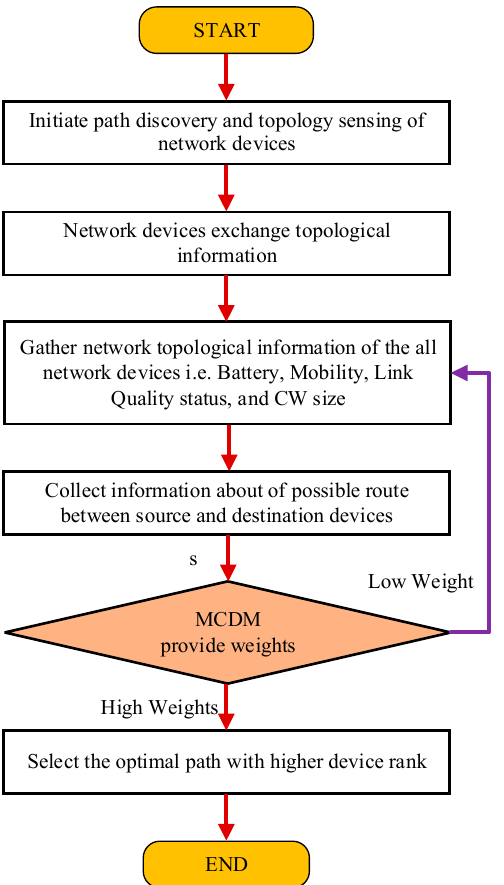
Figure 4. Flow chart of optimal path selection procedure of the MBLCR approach.